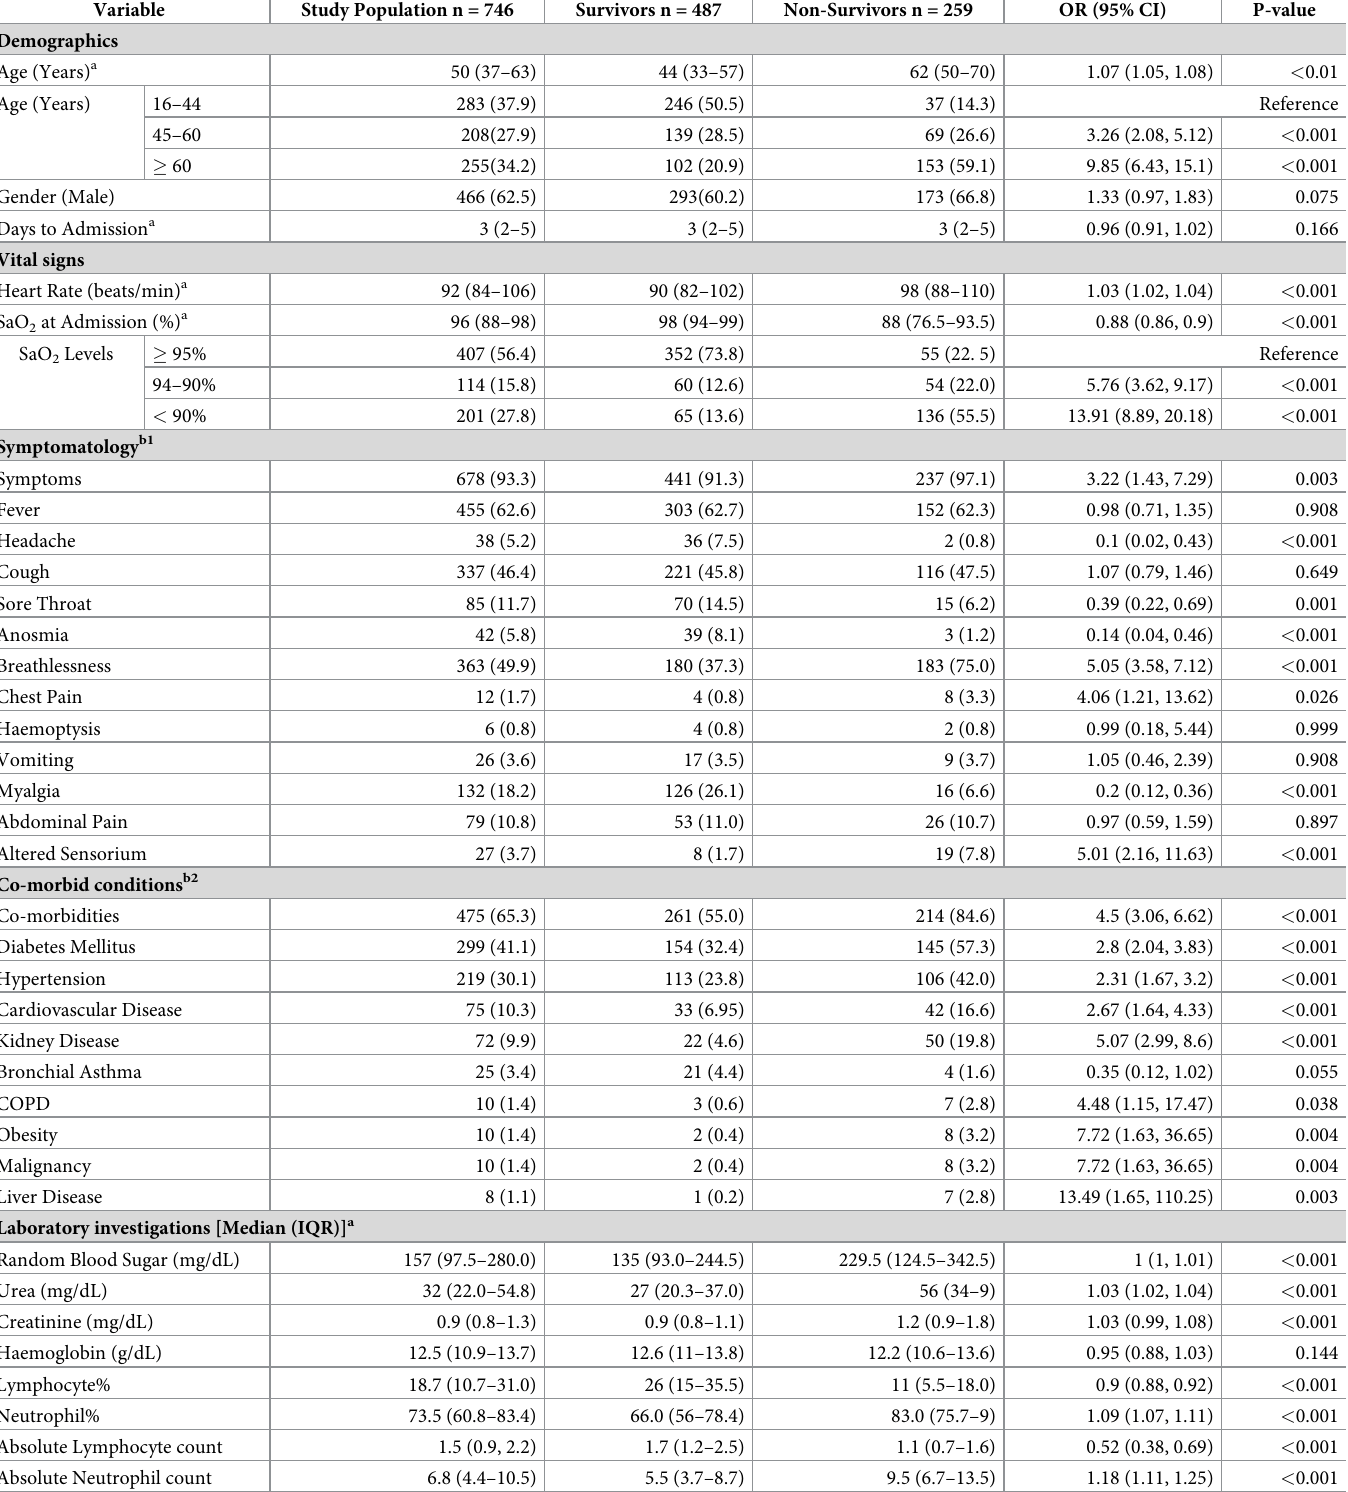
Table 1. Baseline characteristics of hospitalised patients categorised into ‘survivors’ and